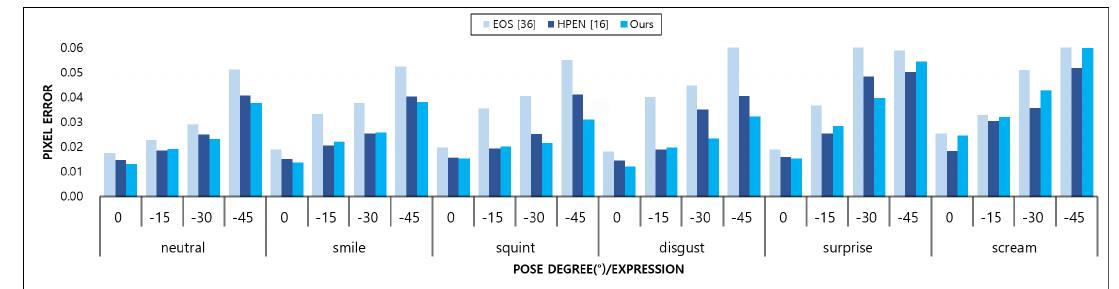
Figure 17. Comparative results on the Multi-PIE dataset [39] for our method and the state-of the-art methods, EOS [38] and HPEN